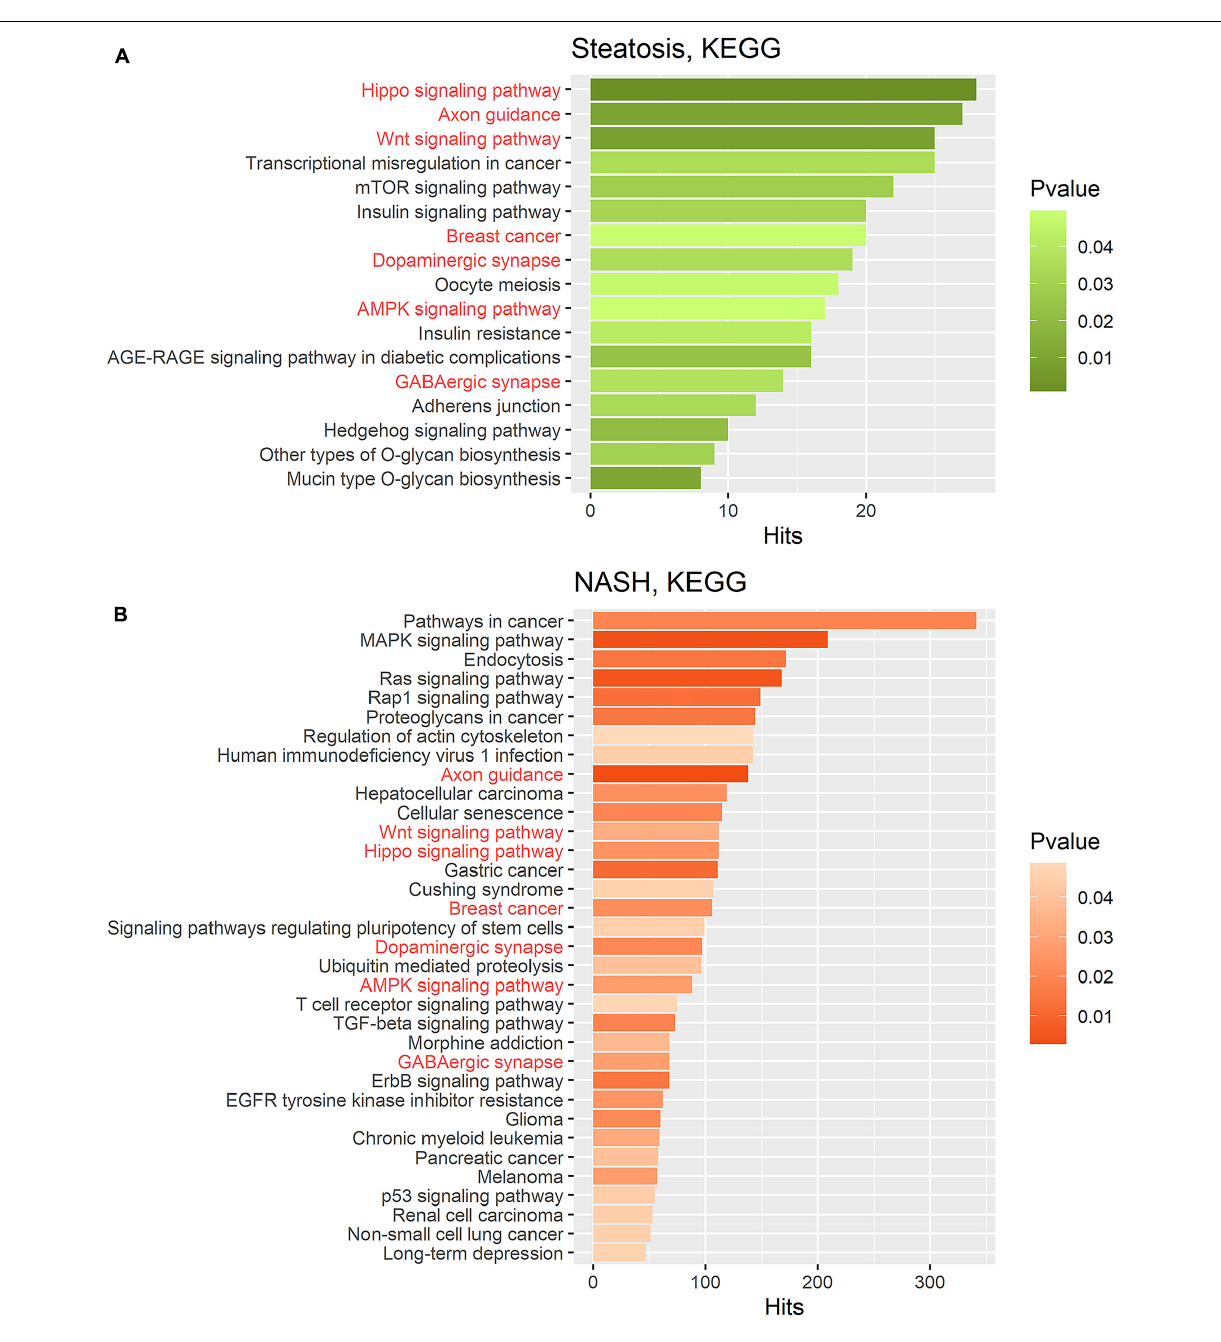
FIGURE 4 | Gene set enrichment analysis performed on the KEGG pathway database for two groups. (A) Target gene set of miRNA that were significantly deregulated in the group of patients with steatosis ( p ≤ 0.05); (B) Target gene set of miRNA that were significantly deregulated in the group of patients with NASH ( p ≤ 0.05). Common pathways in steatosis and NASH are highlighted in red. Hits—number of target genes represented in the